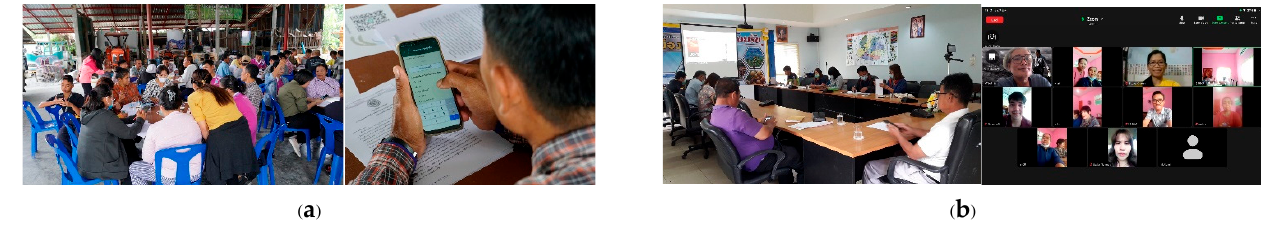
Figure 3. Farmers’ engagement in training workshop and data collection for ( a ) on-site, and ( b )